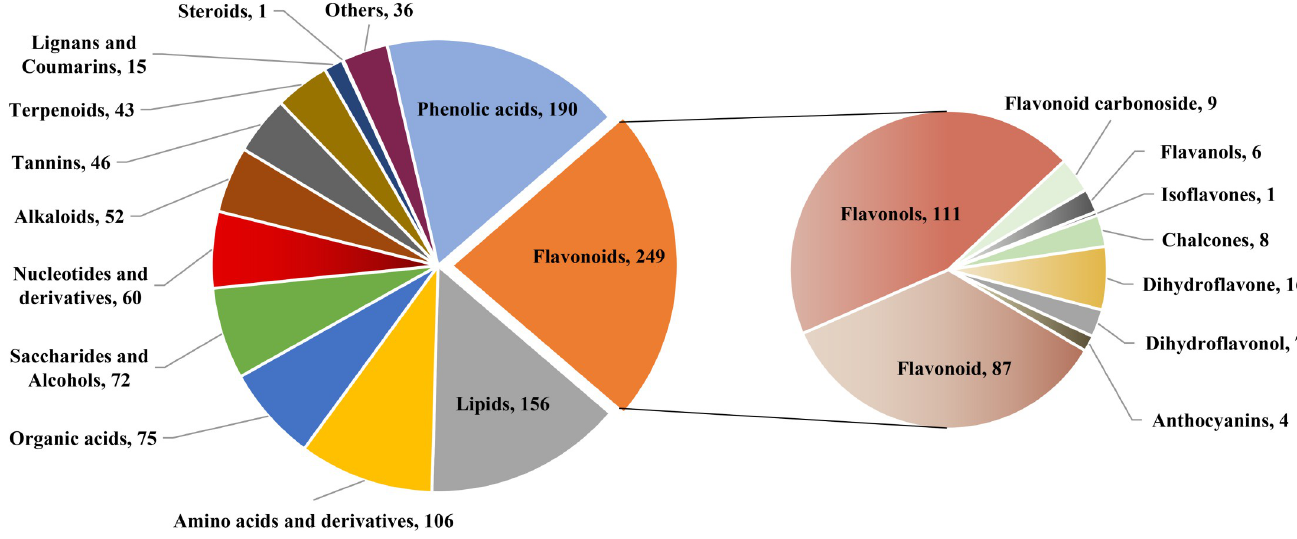
Fig 3. Classification of detected